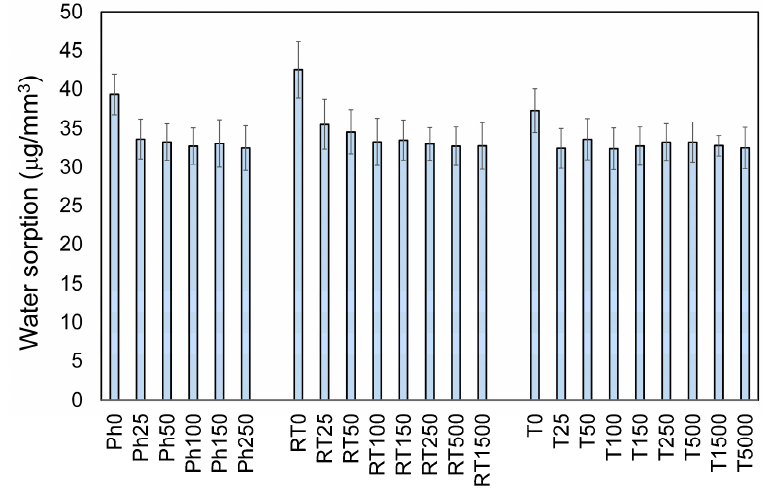
Figure 3. Water sorption of Bis-GMA/TEGDMA/AgNP nanocomposites. The statistically significant results were obtained between pristine polymers and nanocomposites in each series ( p < 0.05).